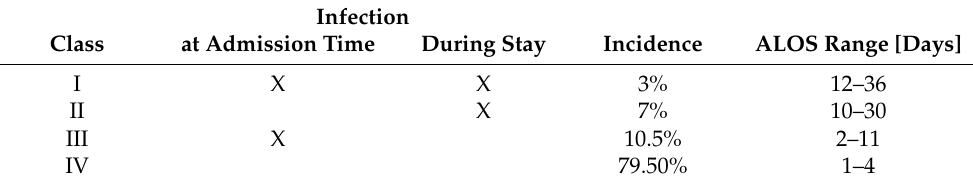
Table 3. Range of length of stay per class of infection. Severity of infection decreases with the